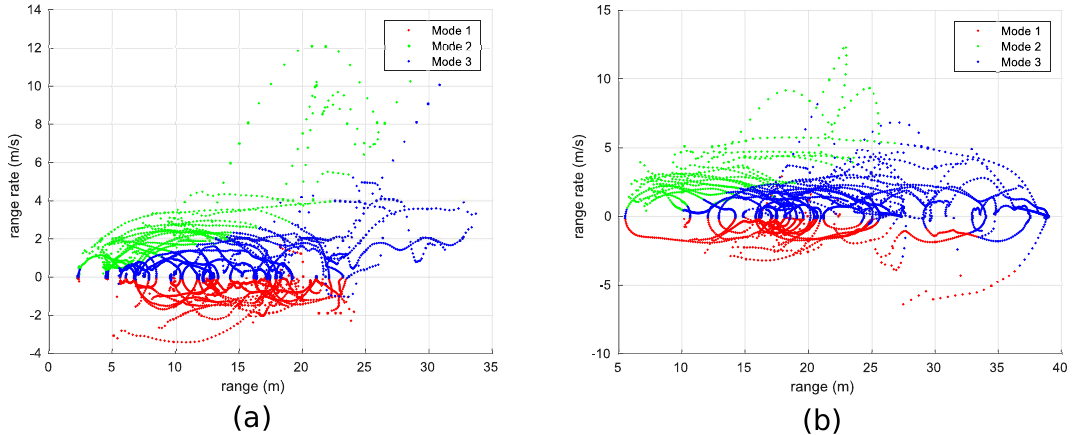
Figure 7. Mode segmentation result (optimal number of sub-models) of the car-following task in the range rate–range space, where a unique color represents a unique mode (sub-model) with its own distinctive motion-control characteristics: ( a ) three-mode model identified for driver A; ( b ) three-mode model identified for driver B.